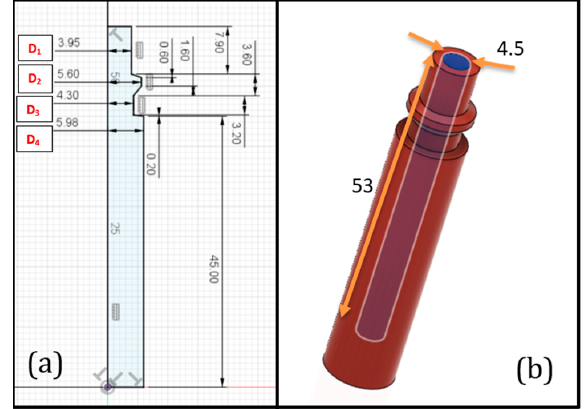
Figure 1. Pneumatic pipe and commercial air connector.